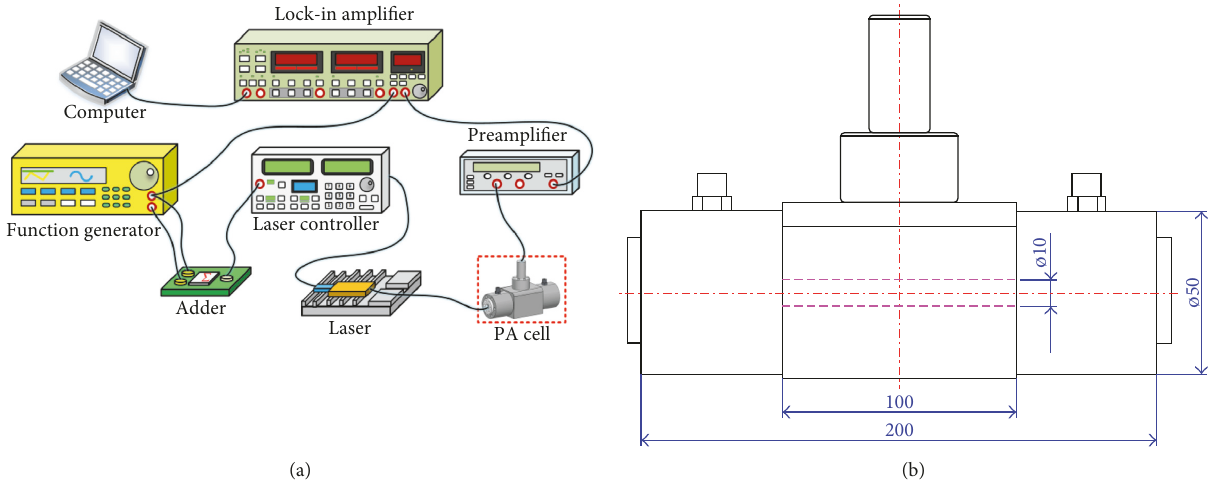
Figure 1: (a) Schematic diagram of the developed C 2 H 6 PAS experimental setup and (b) geometric dimension of the PAS cell.